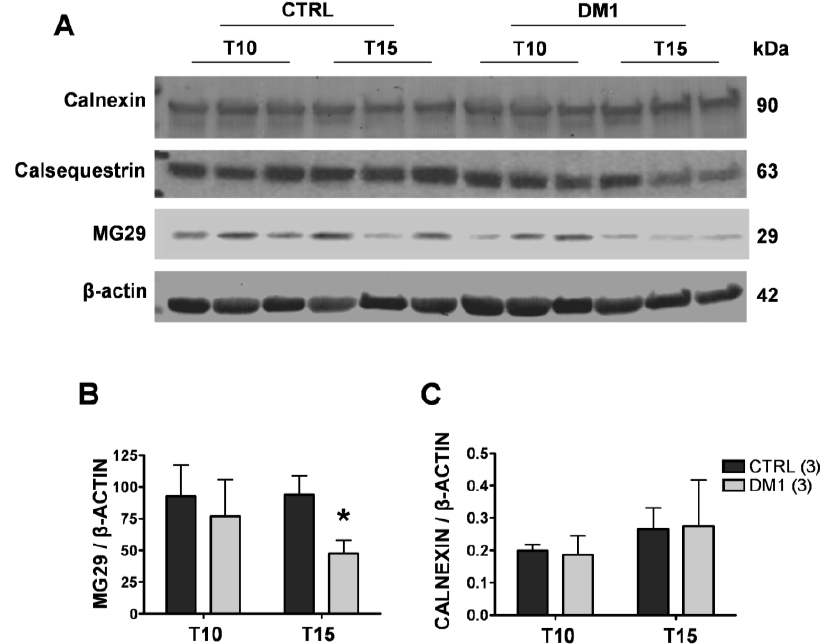
Figure 6. Expression of SR/ER resident proteins in control and DM1 myotubes at 10 (T10) and 15 (T15) days of differentiation. ( A ) Representative Western blot analysis of calnexin, calsequestrin and MG29 in control and DM1 myotubes at 10 and 15 days of differentiation. ( B ) Quantification of MG29 protein levels, normalized to (cid:533) -actin. The values are given in arbitrary units (A.U.) and expressed as mean ± SD of two experiments. * p < 0.05 as compared (cid:87)(cid:82)(cid:3)(cid:70)(cid:82)(cid:81)(cid:87)(cid:85)(cid:82)(cid:79)(cid:86)(cid:3)(cid:69)(cid:92)(cid:3)(cid:54)(cid:87)(cid:88)(cid:71)(cid:72)(cid:81)(cid:87)(cid:86)(cid:182)(cid:3) t test. The numbers of single lines studied is given in